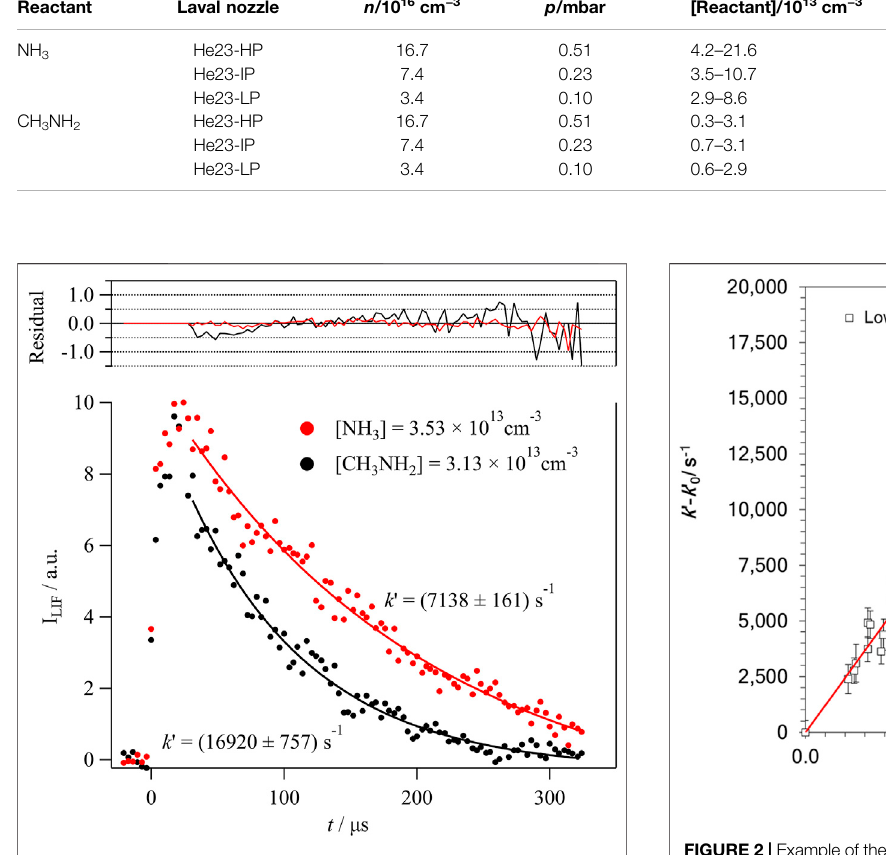
FIGURE 1 | Examples of the I LIF temporal pro fi le in the presence of similarconcentrationsofNH